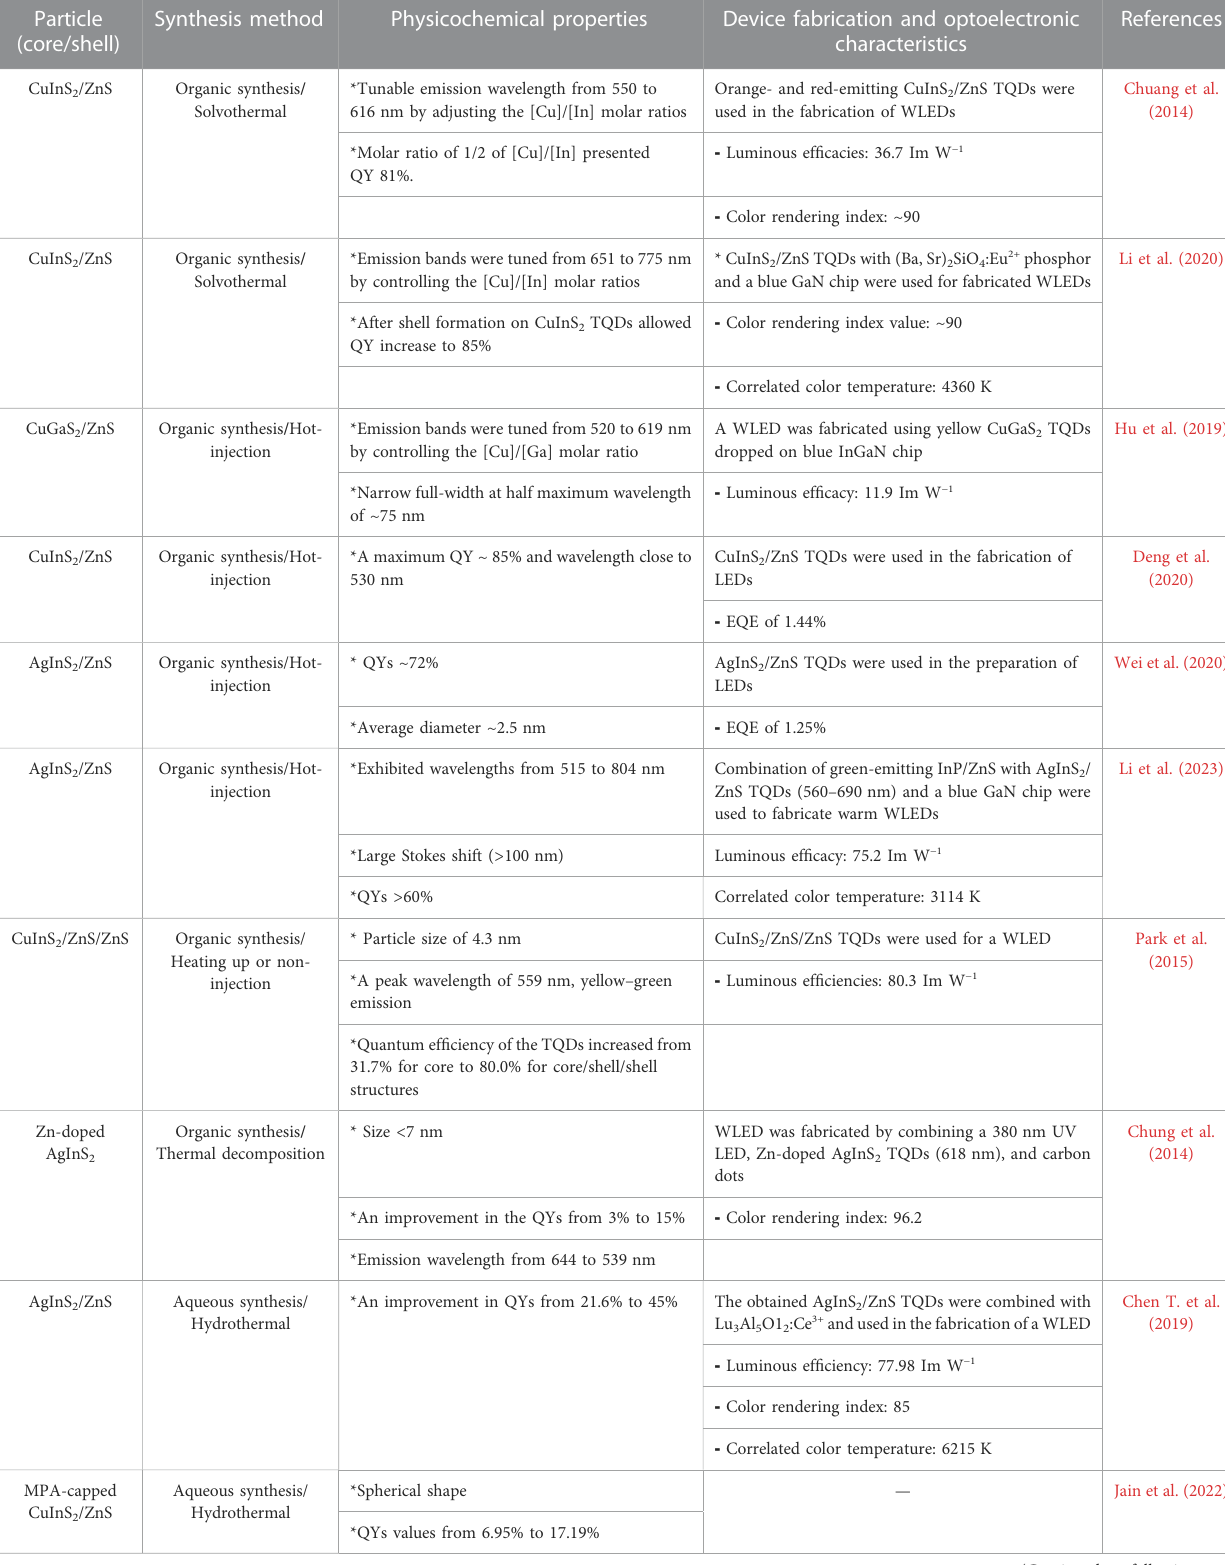
TABLE 1 Overview of organic and aqueous synthesis of TQDs, their properties, and LEDs parameters. Particle